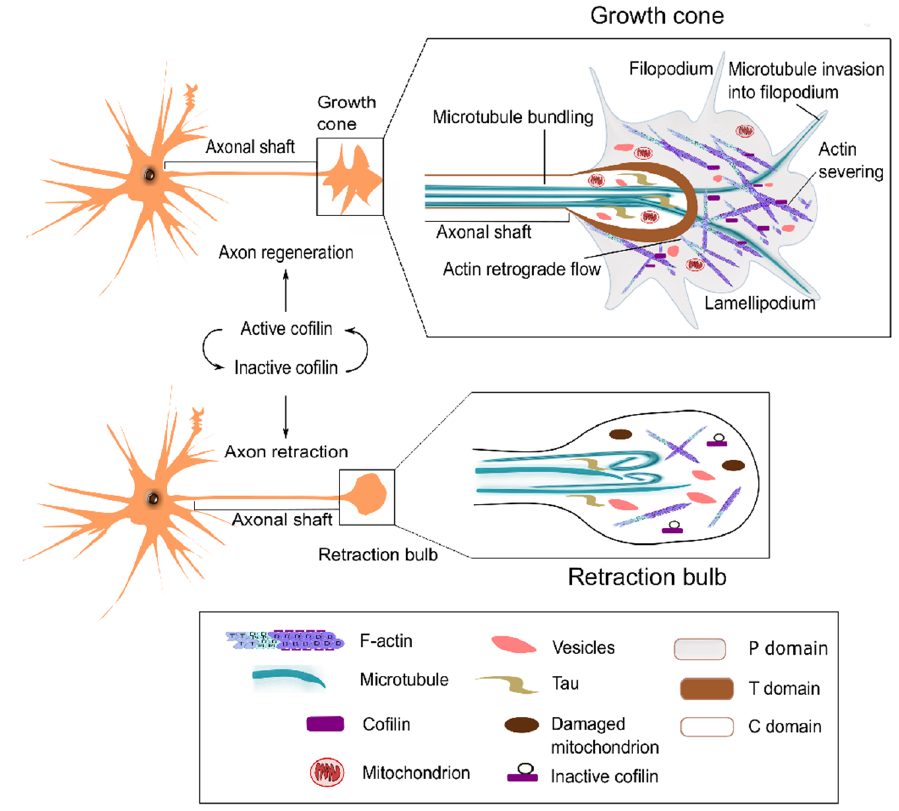
Figure 3. Roles of cofilin in growth cone motility for axonal development. Active cofilin enhances growth cone formation by promoting actin turnover during development and regeneration. Cofilin inactivation suppresses actin turnover, which hinders growth cone development and may cause axonal retraction.